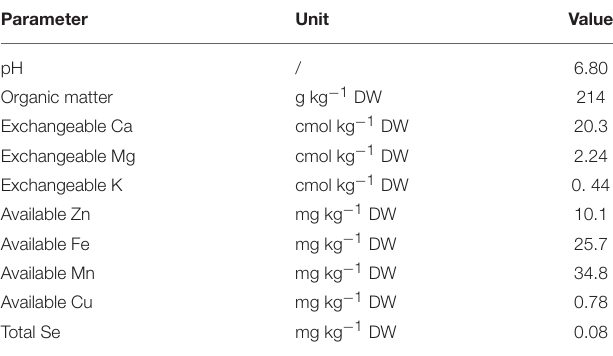
TABLE 1 | Parameters of the soil used in the